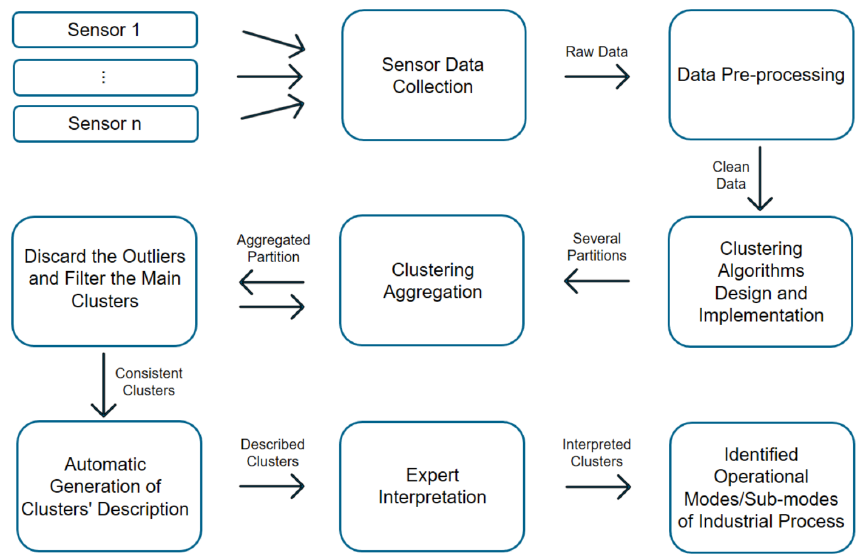
Figure 2. Chart of the proposed methodology pipeline to identify unknown operational modes through an ensemble of clustering